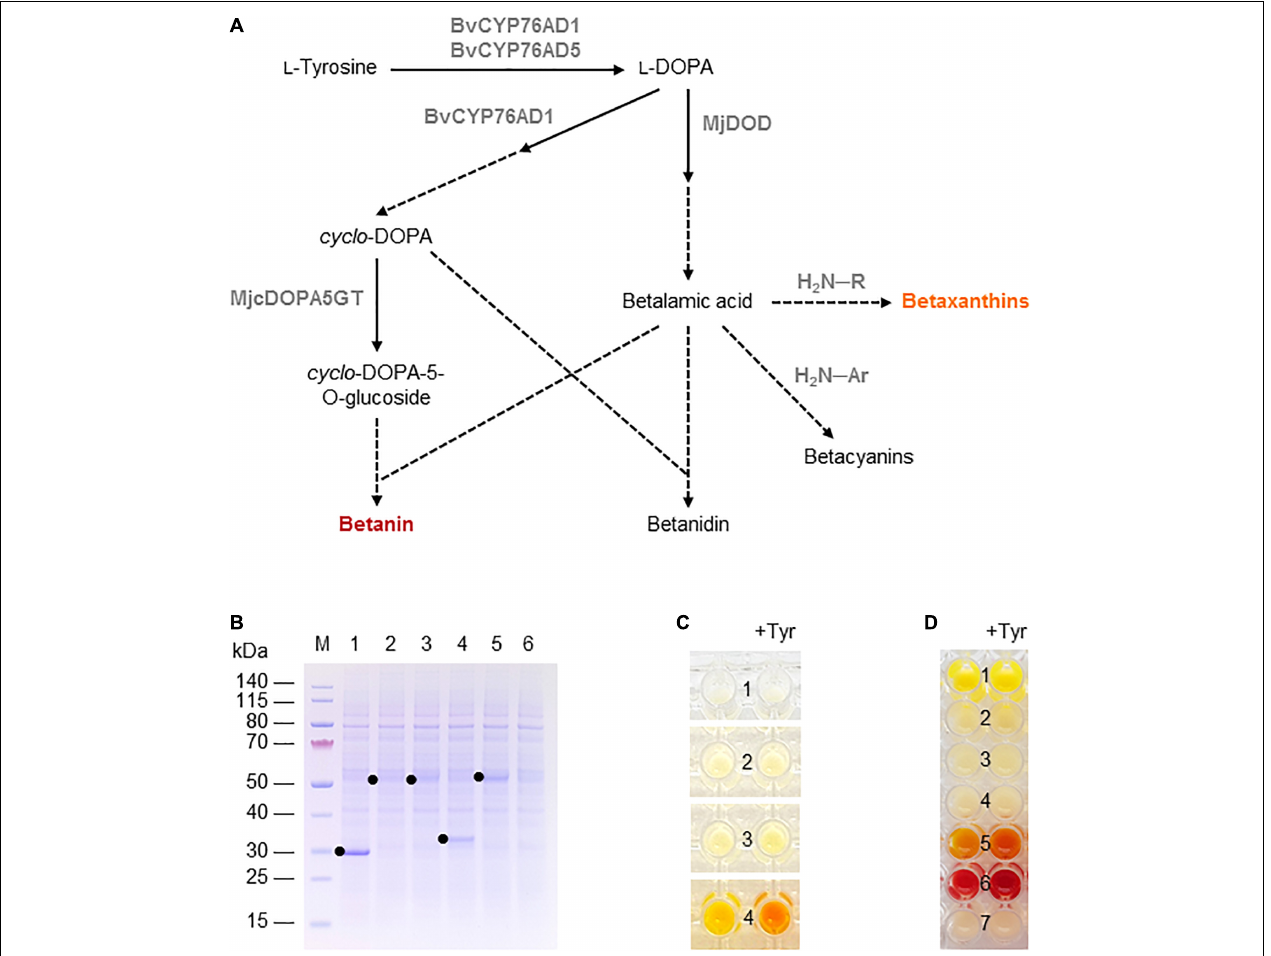
FIGURE 3 | Betalain biosynthesis in the BY-2 cell-free system. (A) Schematic overview of the betalain biosynthesis pathway. Solid lines are enzymatic reactions and dashed lines are spontaneous reactions. R = any organic group; Ar = any organic aromatic group. (B) SDS-PAGE analysis of BYL transcription–translation reactions after incubation for 44 h at 25 ◦ C and 70% humidity, shaking at 500 rpm. In each case, 0.5 µ L of the reaction mix was loaded onto a 4–12% (w/v) gradient gel. Lane 1: Strep-eYFP (29 kDa), lane 2: BvCYP76AD1_W13L (56 kDa), lane 3: BvCYP76AD5 (57 kDa), lane 4: MjDOD (30 kDa), lane 5: MjcDOPA5GT (57 kDa). (C) Image of the in vitro reactions for betaxanthin biosynthesis after incubation for 24 h: (1) no-template control, (2) BvCYP76AD5, (3) MjDOD, and (4) BvCYP76AD5 + MjDOD. Reactions were supplemented with 5 mM L -tyrosine (Tyr) as indicated. (D) Image of the in vitro reactions for betacyanin biosynthesis after incubation for 24 h: (1) Strep-eYFP, (2) BvCYP76AD1_W13L, (3) MjDOD, (4) MjcOPA5GT, (5) BvCYP76AD1_W13L + MjDOD, (6) BvCYP76AD1_W13L + MjDOD + MjcOPA5GT, and (7) no-template control. Reactions were supplemented with 5 mM L -tyrosine (Tyr) as